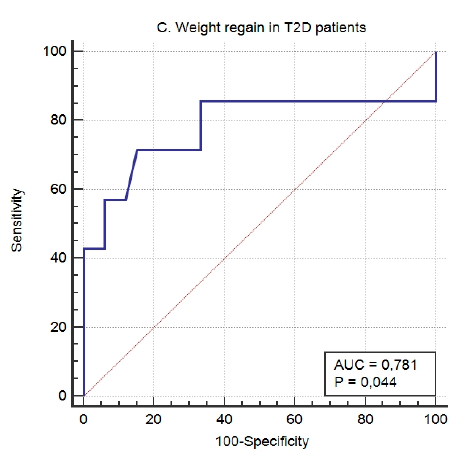
Figure 2. The predictive capacity of the genetic score for weight regain after 5 years’ follow-up in the whole ( A ) population, non-T2D subjects ( B ), and T2D patients ( C ). Diabetes remission was seen in 73.91% of the type 2 diabetic patients included in the study (66.67% in the group of %EWL < 40% and 77.42% in the group of %EWL > 75%). Diabetes relapse was seen in 25% of the patients.